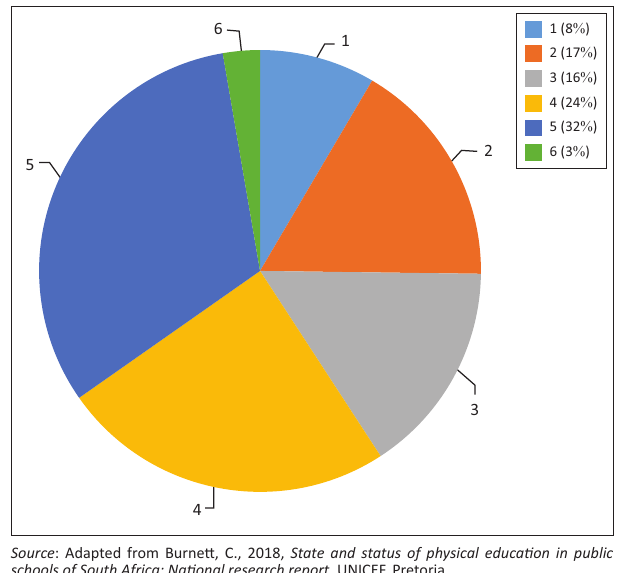
FIGURE 1: Participating primary schools per province.